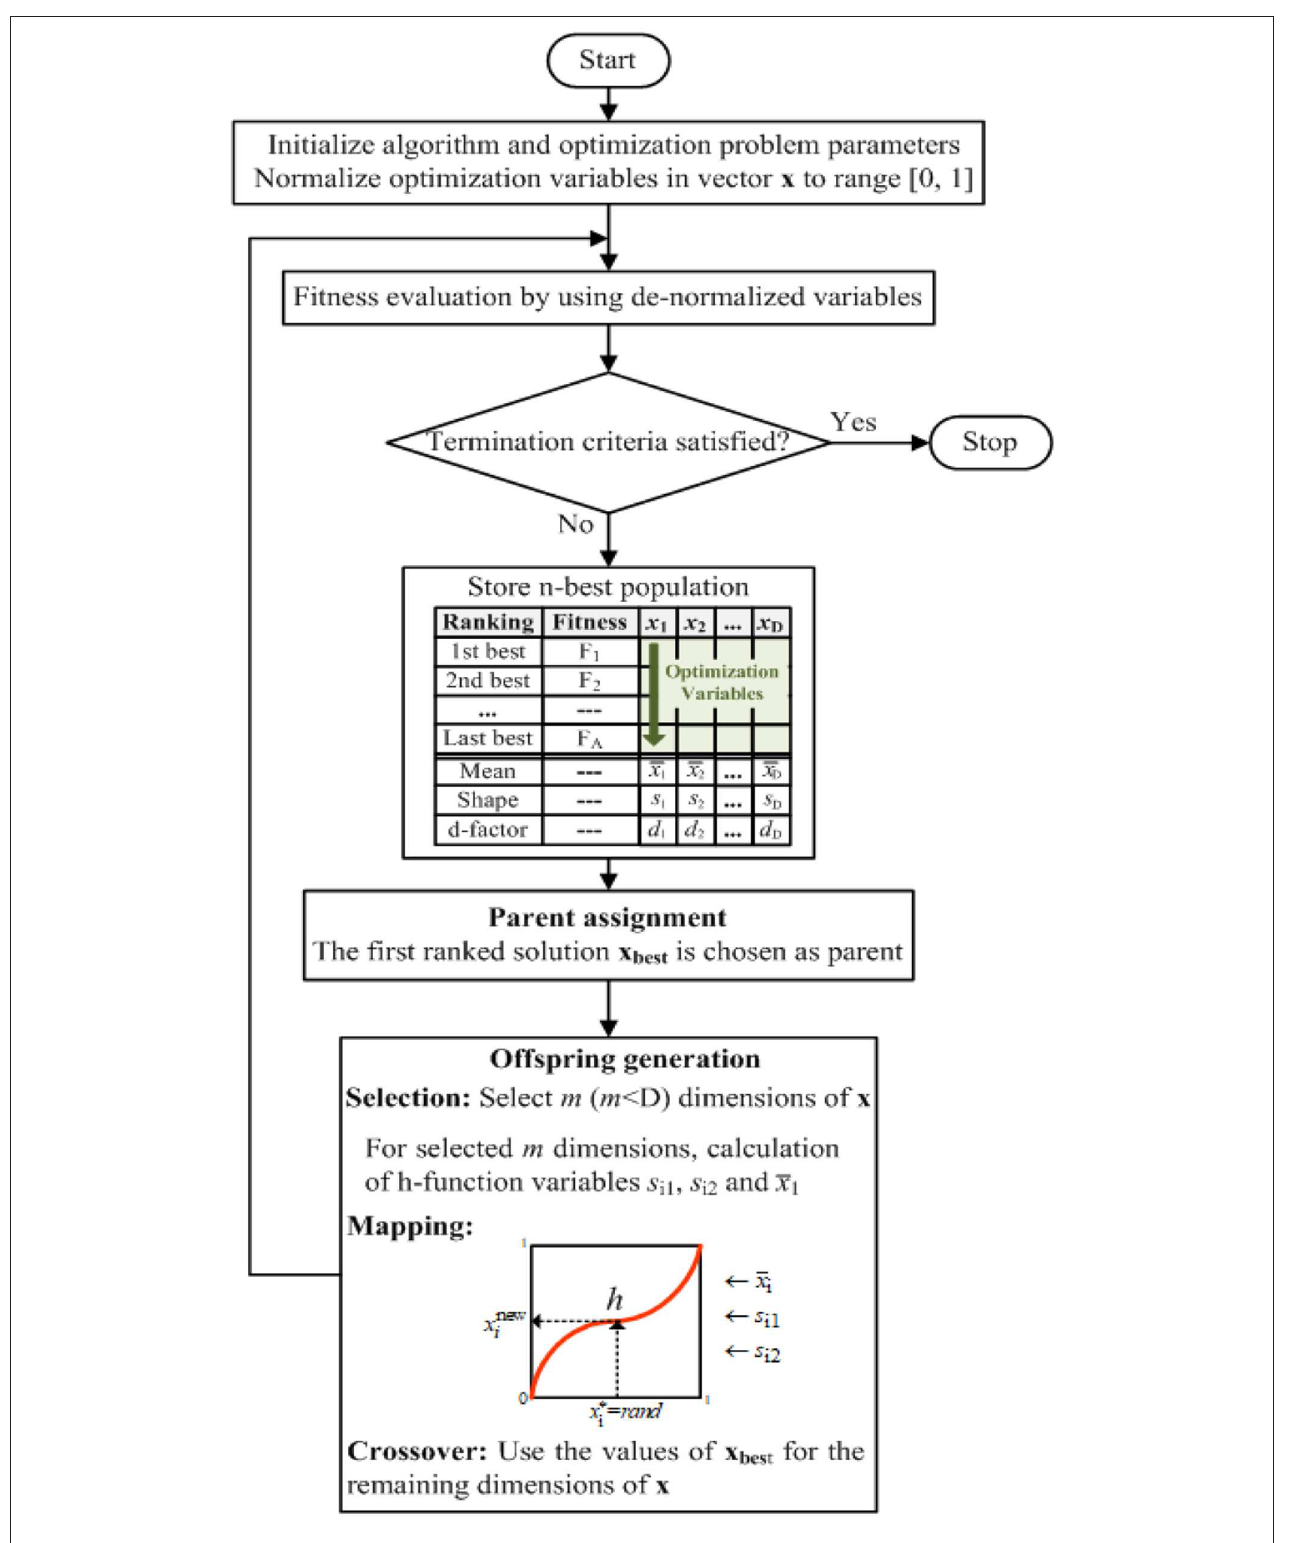
FIGURE 6 | Flow chart of